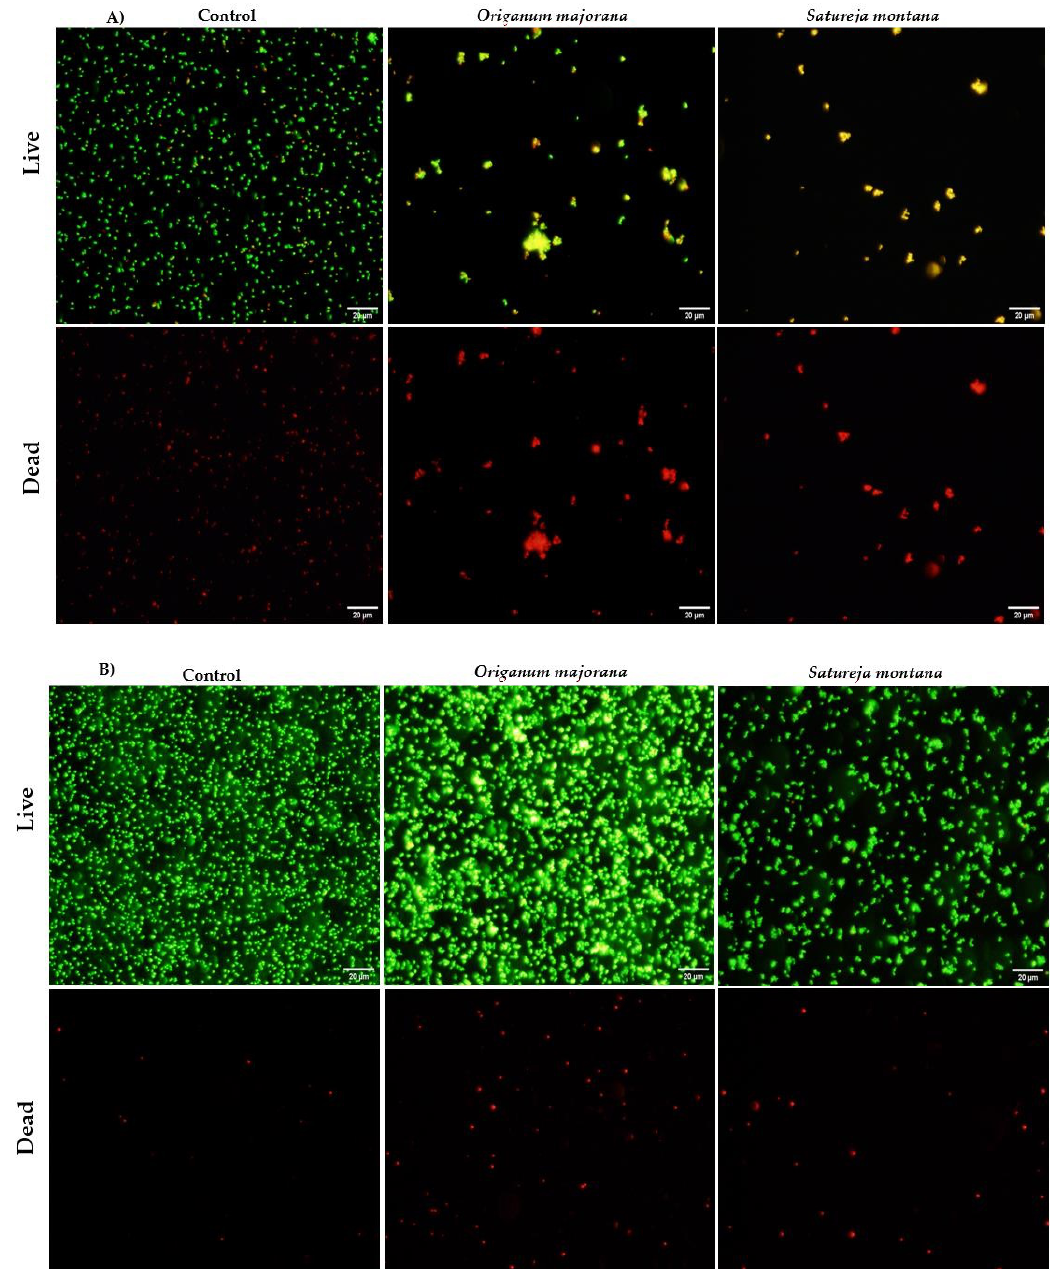
Figure 2. Live/dead cell viability images of S. aureus following 3 h ( A ) and 24 h ( B ) exposure to 0 (control—untreated cells) and 1.56 mg/mL of Origanum majorana and Satureja montana decoctions. Live cells were stained with green and dead cells were stained with red. Magnification 400×. Scale bar = 20 µm.